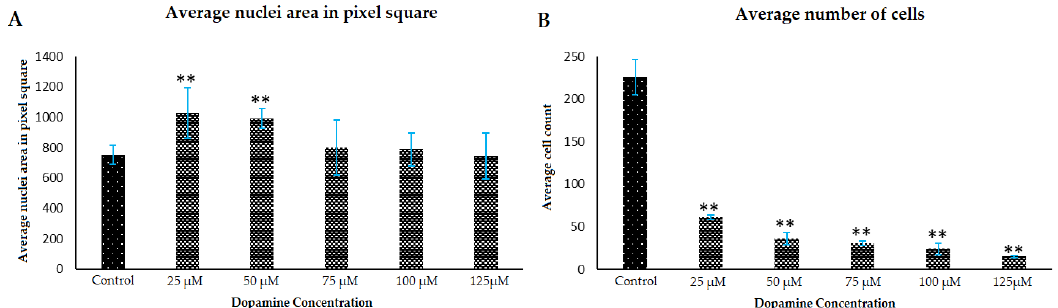
Figure 5. Morphology and number of the astrocyte nuclei in presence of DA and PDA. Astrocytes were plated at 5000 cells/well each, allowed to grow for 5 days, and then were treated with different concentrations of DA, allowing PDA to form for the next 2 days. Thereafter, cells were washed and fixed. DAPI staining (see Methods) was performed to check for morphological changes in nuclei area (panel ( A )) and number of nuclei (panel ( B )). Data are averages from multiple platings of cells for each condition and ** denotes p < 0.01 compared to control condition.